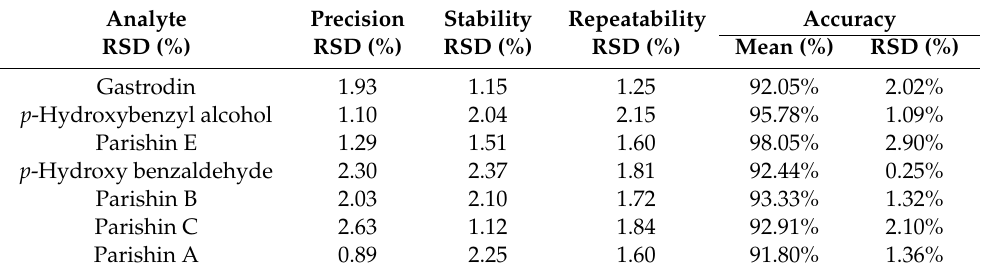
Table 2. RSD of precision, stability, repeatability and accuracy for determination of seven components.